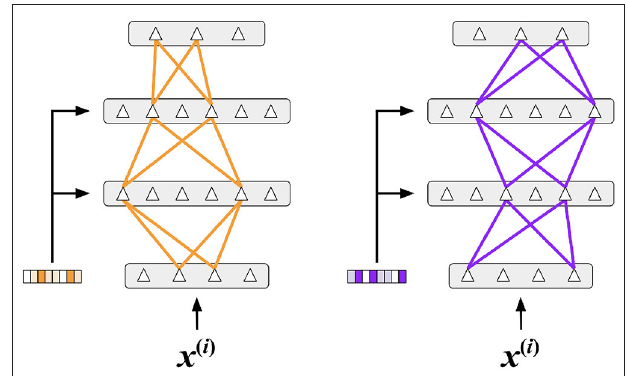
FIGURE 14 | A representation of subnetworks within an Active Dendrites Network. By receiving different context vectors as input, dendritic segments invoke different subnetworks for a fixed feedforward input. The subnetworks are distributed, i.e., they may share some of the same neurons.